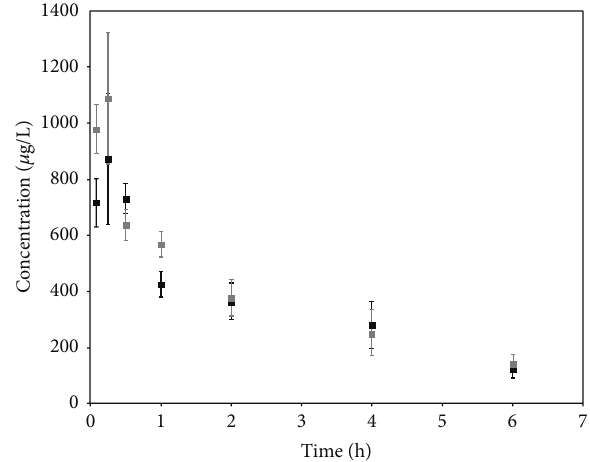
Figure3:Meanplasmaconcentration-timecurvesofcepharanthine in healthy (bold square) and Plasmodium berghei ANKA infected mice (gray square) after intraperitoneal administration of cepharan- thine at the dose of 21mg/kg.